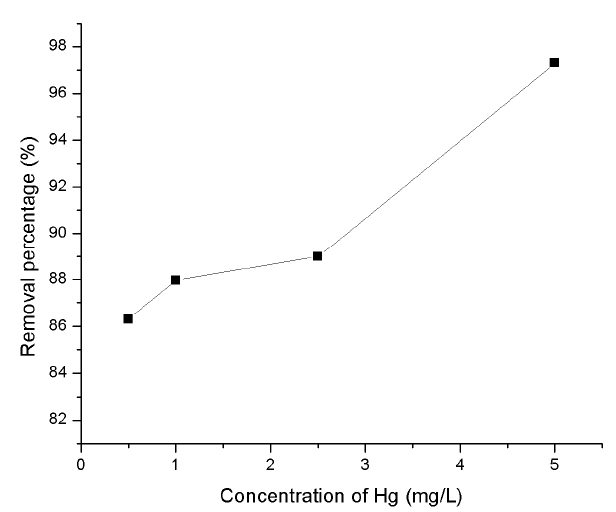
Figure 6. The removal percentages of mercury when the concentration increases from ppb to ppm.